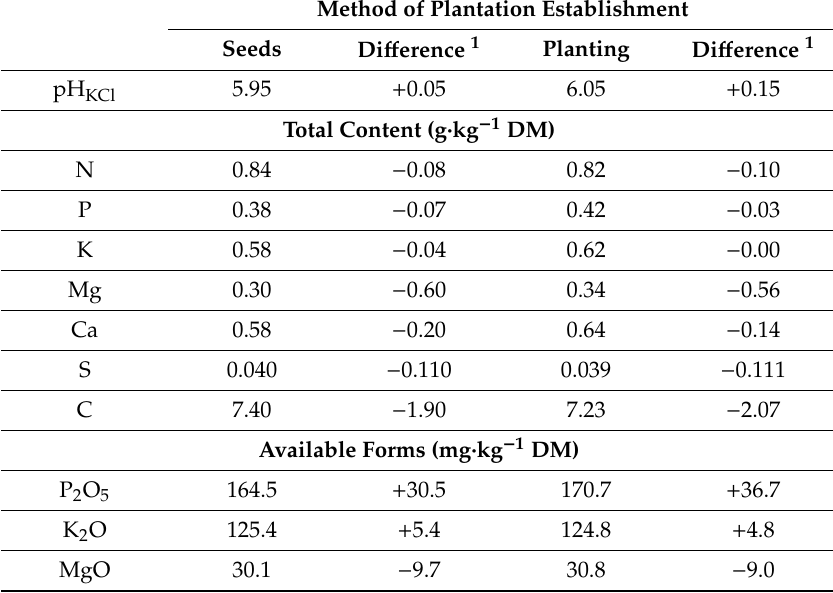
Table 13. The characteristic of the soil taken from 0–30 layer after harvest of Silphium in 2019, depending on the methods of plantation establishment. Method of Plantation Establishment Seeds Di ff erence 1 Planting Di ff erence